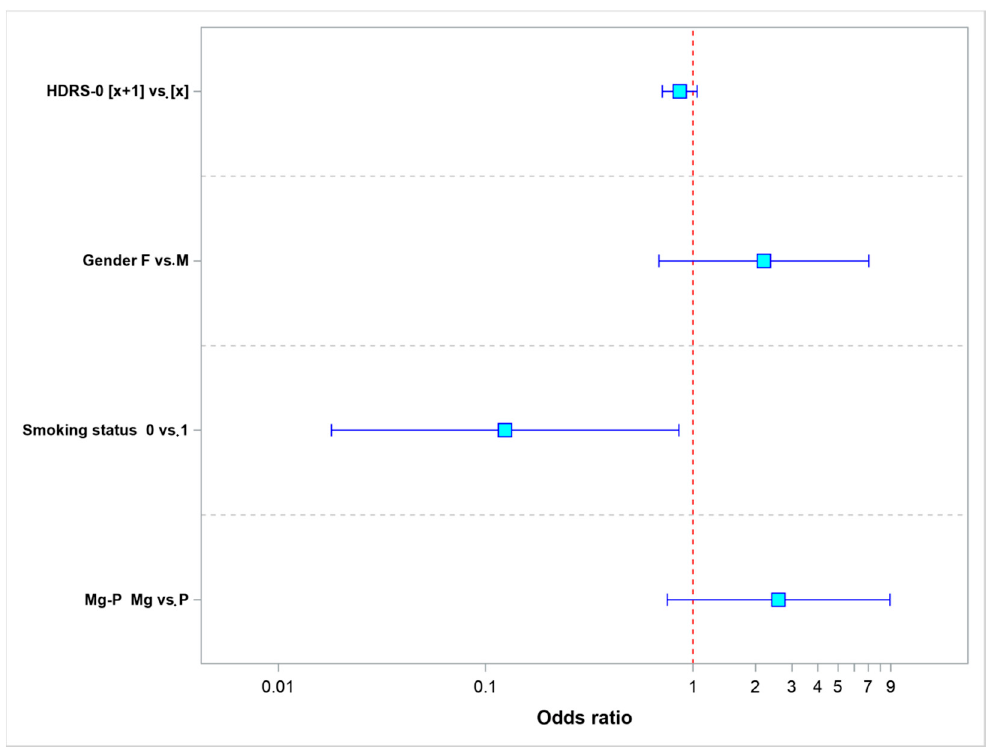
Figure 4. Odds ratio values for treatment efficacy.